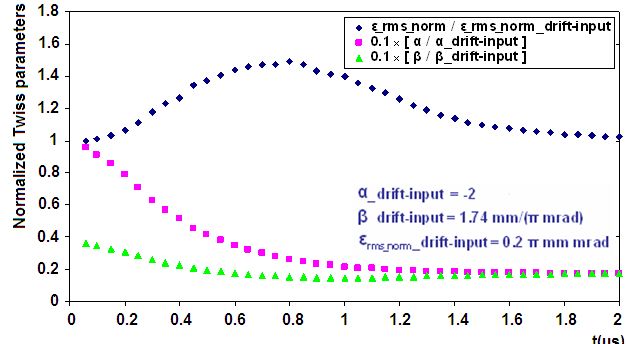
FIG. 13. (Color) Normalized beam Twiss parameters time evo- lution at the drift exit.